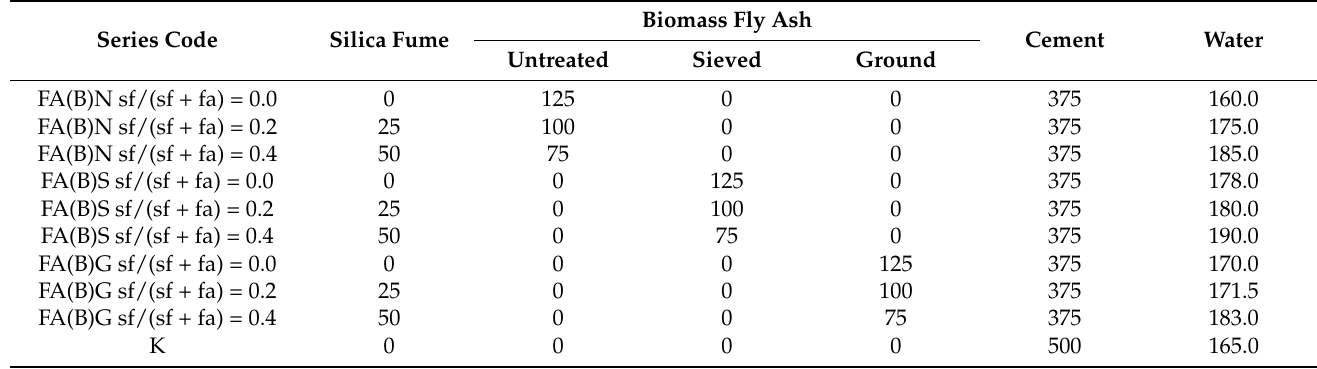
Figure 3. Grain-size distribution of fly ash activated by the addition of 40% of silica fume compared to the grain-size distribution of untreated fly ash (logarithmic scale). Different means of modification resulted in different water demands of activated fly ash, expressed as the amount of water needed to achieve a normal consistency (Table 6). Sieved fly ash needed 11% more water than untreated fly ash while ground fly ash re- quired 6% more than untreated fly ash. The addition of 20% of silica fume to fly ash re- sulted in a marginal difference in water demand when ground or sieved fly ash was used. It might imply a good interaction of both activation means on the modification of fly ash compactness and its specific surface. Sieved biomass fly ash had a higher 28-day strength activity index, which was also higher than the EN 450-1 requirement of 75% (Table 7). Table 7. Physical Properties of Activated Biomass Fly Ash. Property